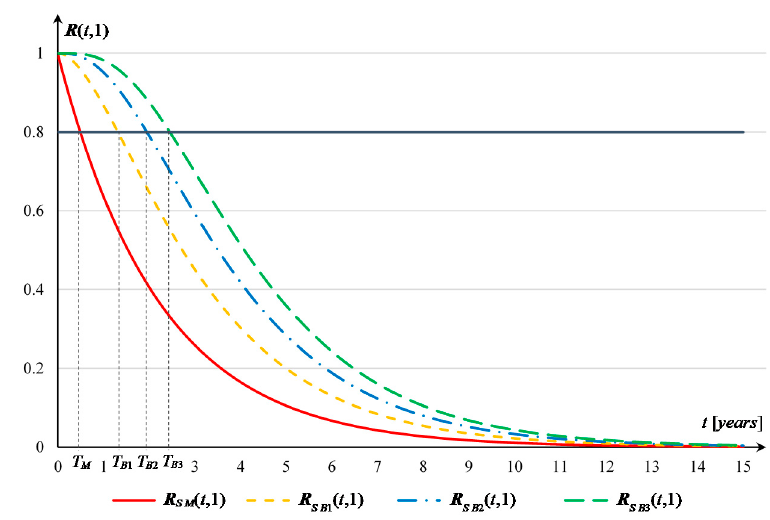
Figure 5. Graph of reliability function coordinate R ( t , 1) for a navigation system in various configurations.